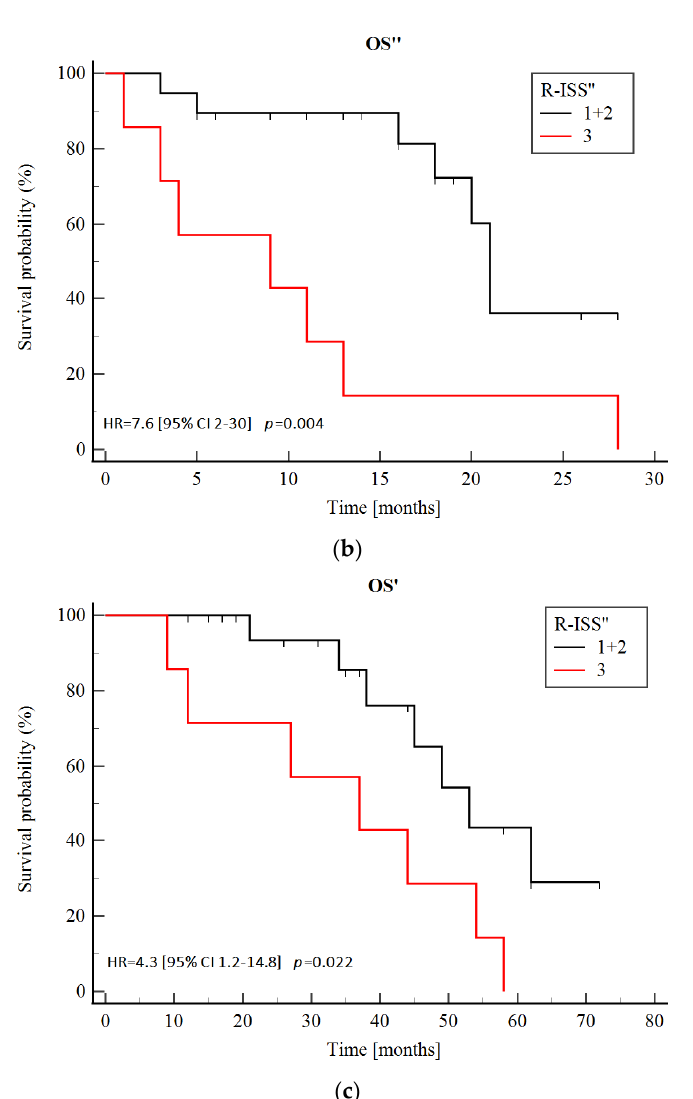
Figure 5. Kaplan–Meier survival curves for ( a ) PFS, ( b ) OS after the paired sample collection (OS”) and ( c ) OS after the first sample collection (OS’) according to the R-ISS’’ (assessed at the time of the paired sample collection). The comparison of survival groups was assessed by log rank test ( p values).